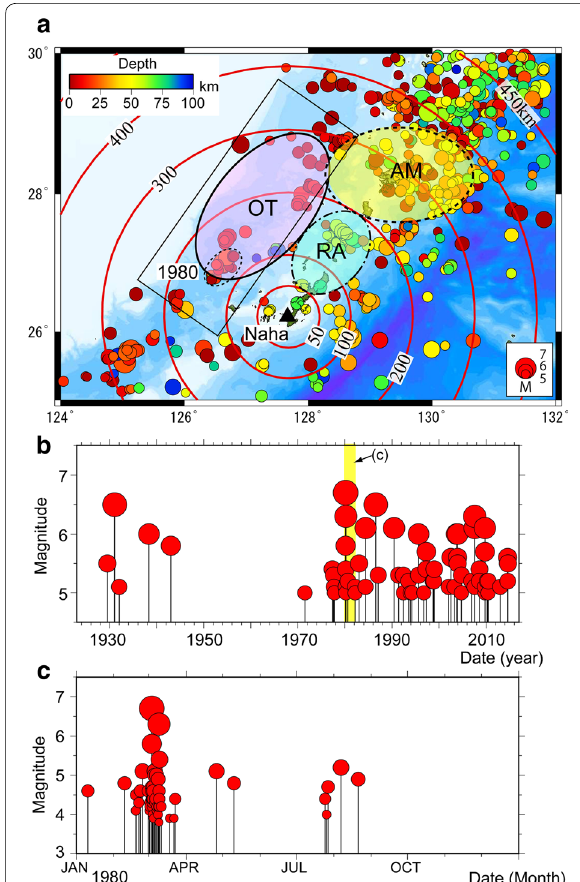
Fig. 4 Candidate source areas for the epicenters of the 1858 earth‑ quake swarm. a Seismicity for earthquakes with magnitude >5.0 since 1923. Circles show the hypocenters of earthquakes shallower than 100 km that were catalogued by the JMA. Candidate source areas for the 1858 swarm are shown by the red solid (Okinawa Trough area: OT), yellow dotted (Amami Island area: AM), and blue dot dashed (Ryukyu Arc area: RA) ellipses. Transparent dotted ellipse denotes the epicenters of the 1980 swarm. Red-colored contours show the distance from Naha; solid black triangle shows the location of Naha. b Magnitude–time diagram for earthquakes with magnitude >5.0 in the central OT, denoted by the solid rectangle in ( a ). c Magnitude– time diagram for the 1980